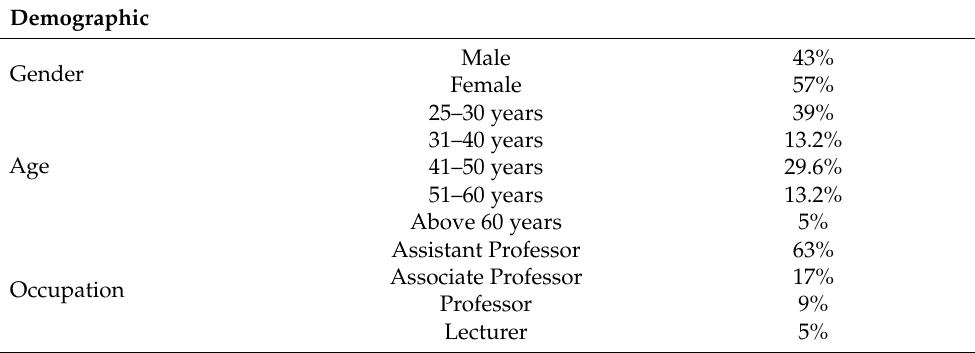
Table 3. Demographic representation of